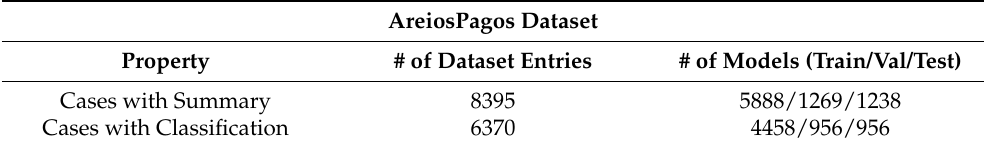
Table 1. Basic statistics for AreiosPagos dataset and trained